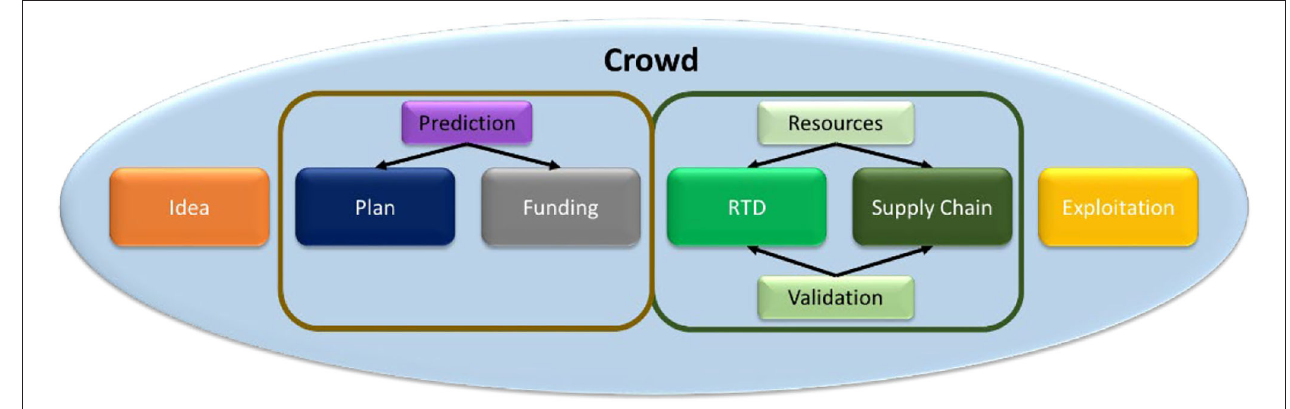
FIGURE 4 | Involvement of the “Crowd” along the entire value creation from idea to delivery and exploitation. Energized by a blockchain-implemented token economy, prediction markets for planning are backed by collective intelligence while work and validation on RTD and supply chain are crowdsourced through competitive parallelization as outlined in the green-framed box and further illustrated in Figure 5